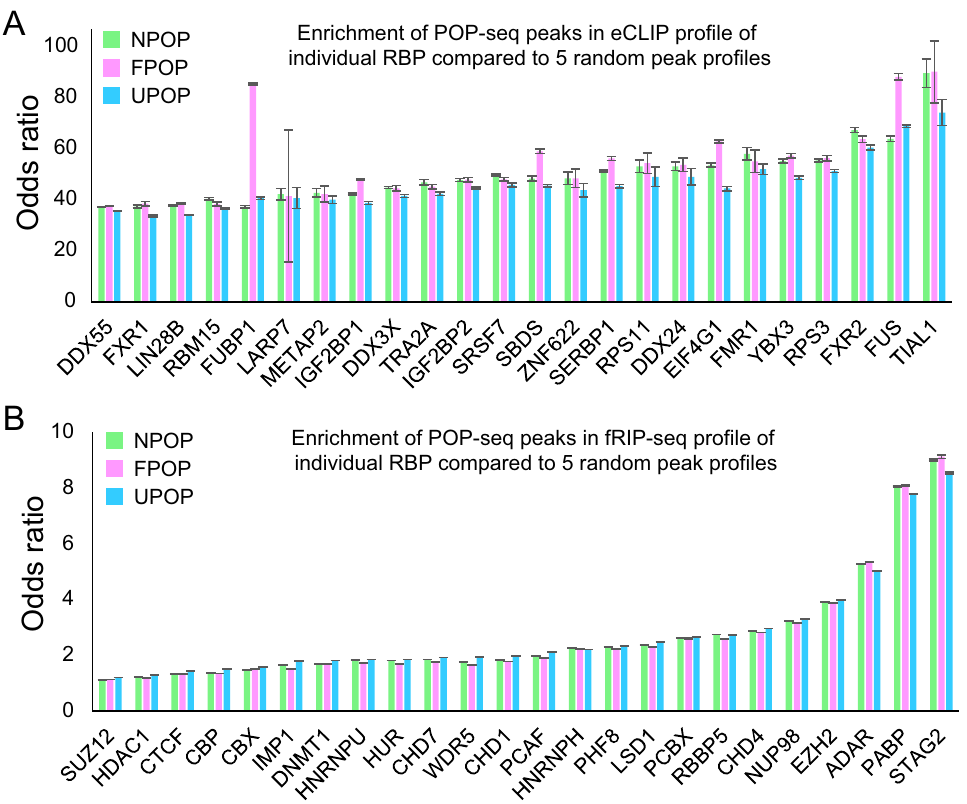
Figure 3. Comparison of POP-seq peaks with RBP centric peaks derived from orthogonal assay. Bar plot showing the enrichment of POP-seq peaks in ( A ) eCLIP and ( B ) fRIP-seq profiles of individual RBP in K562 cells, compared to 5 random peak profiles and statistically tested using Fisher’s exact